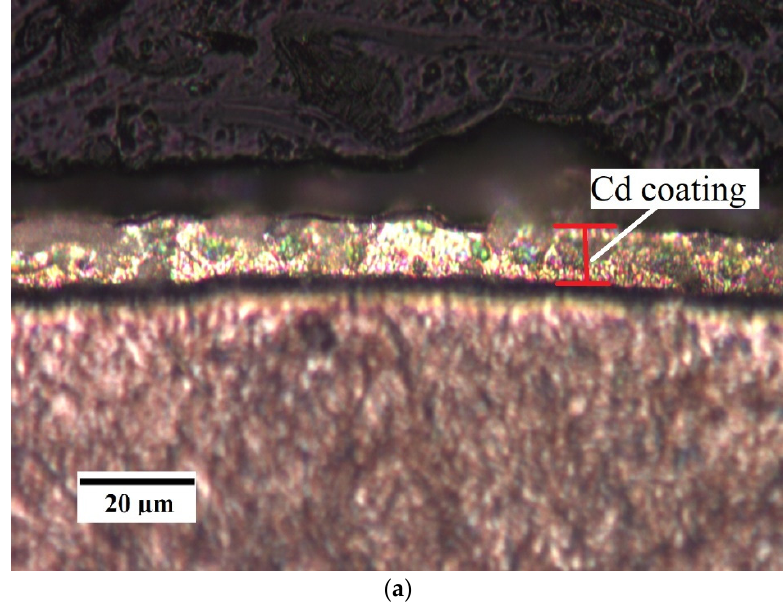
Figure 5. Microstructure after ( a ) 2% Nital etching (200×), ( b ) 10% sodium metabisulfite etching (500×), ( c ) reagent LePera etching–OM (500×).